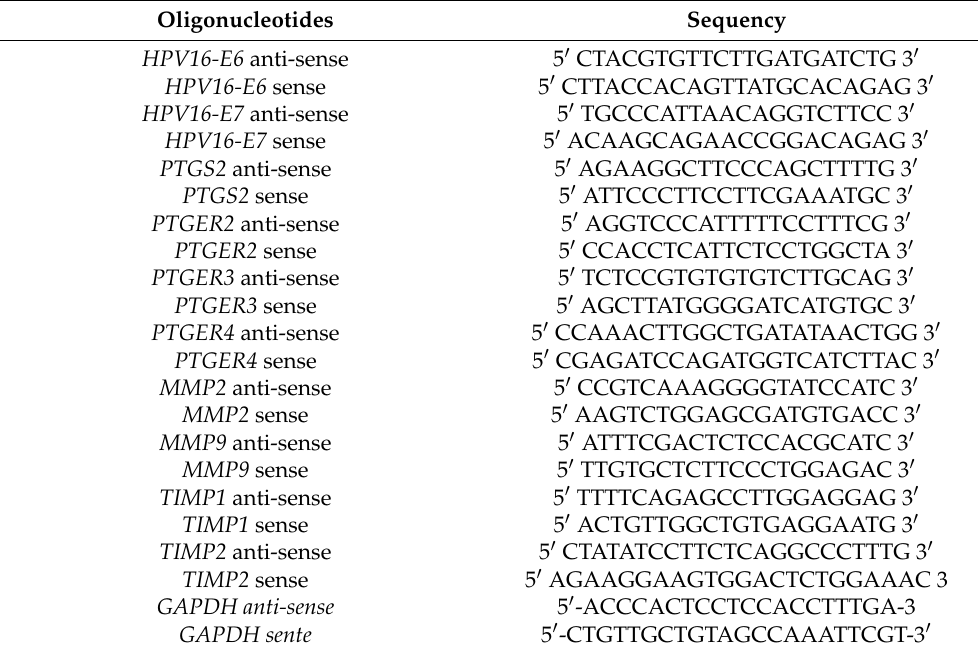
Table 2. Primers used in real-time